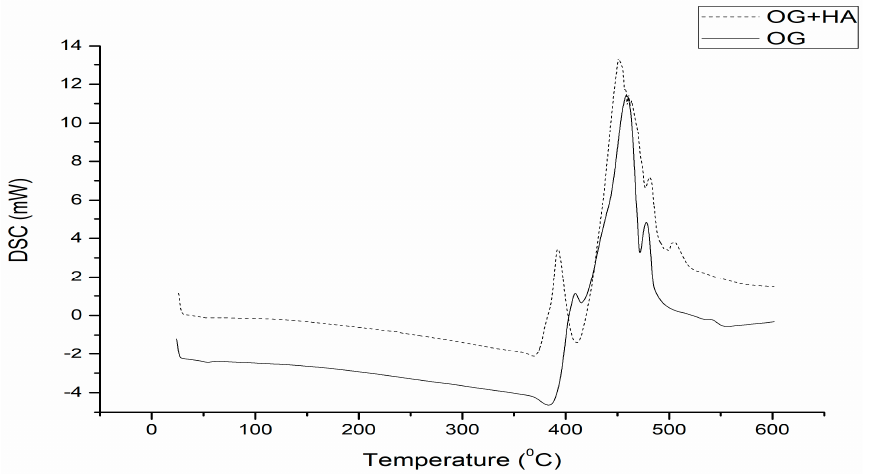
Figure 4. Differential exploratory calorimetry curve of OG and OG + HA in N 2 atmosphere (50 mL/min) and 10 °C/min heating, over a temperature range from 25 to 550 °C.